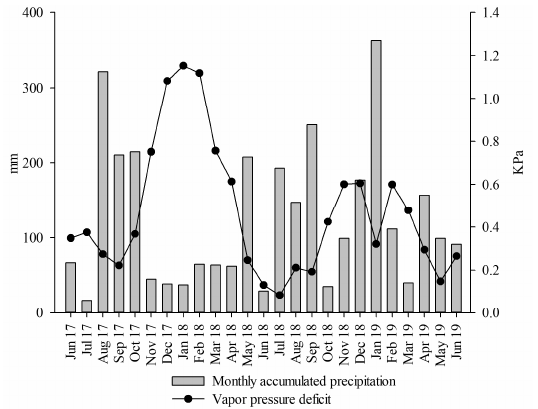
Figure 1. Evolution of monthly accumulated precipitation (mm) (left Y axis) and vapor pressure deficit (KPa) (right Y axis) for the study period.